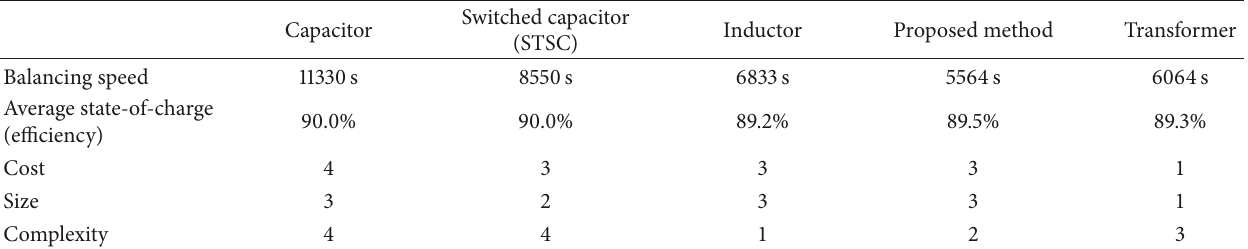
Table 4: Comparison of different active cell balancing methods at 25 ∘ C.